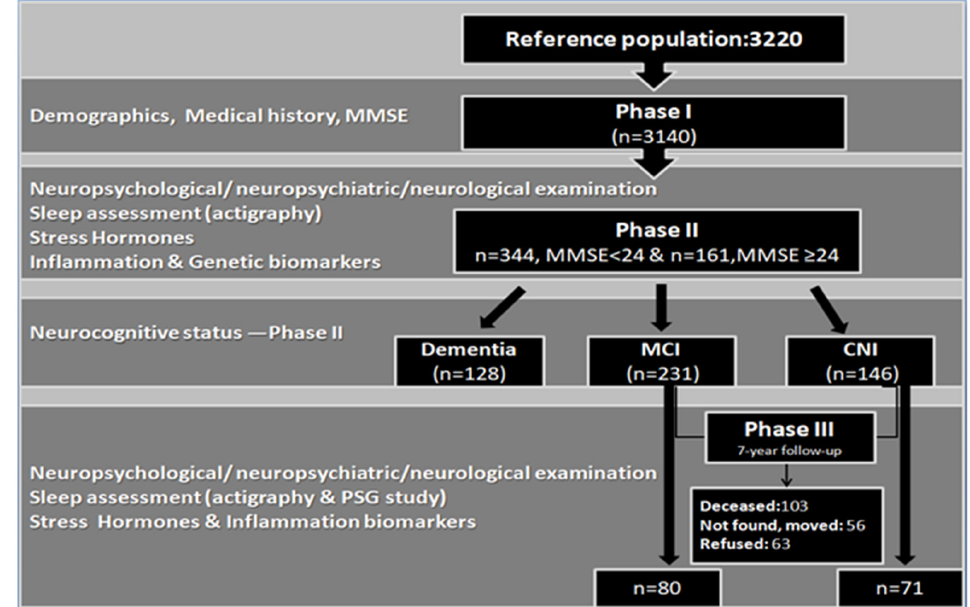
Figure 1. Flow diagram of Phases I,II &III of the Cretan Aging Cohort study. Phases I & II were